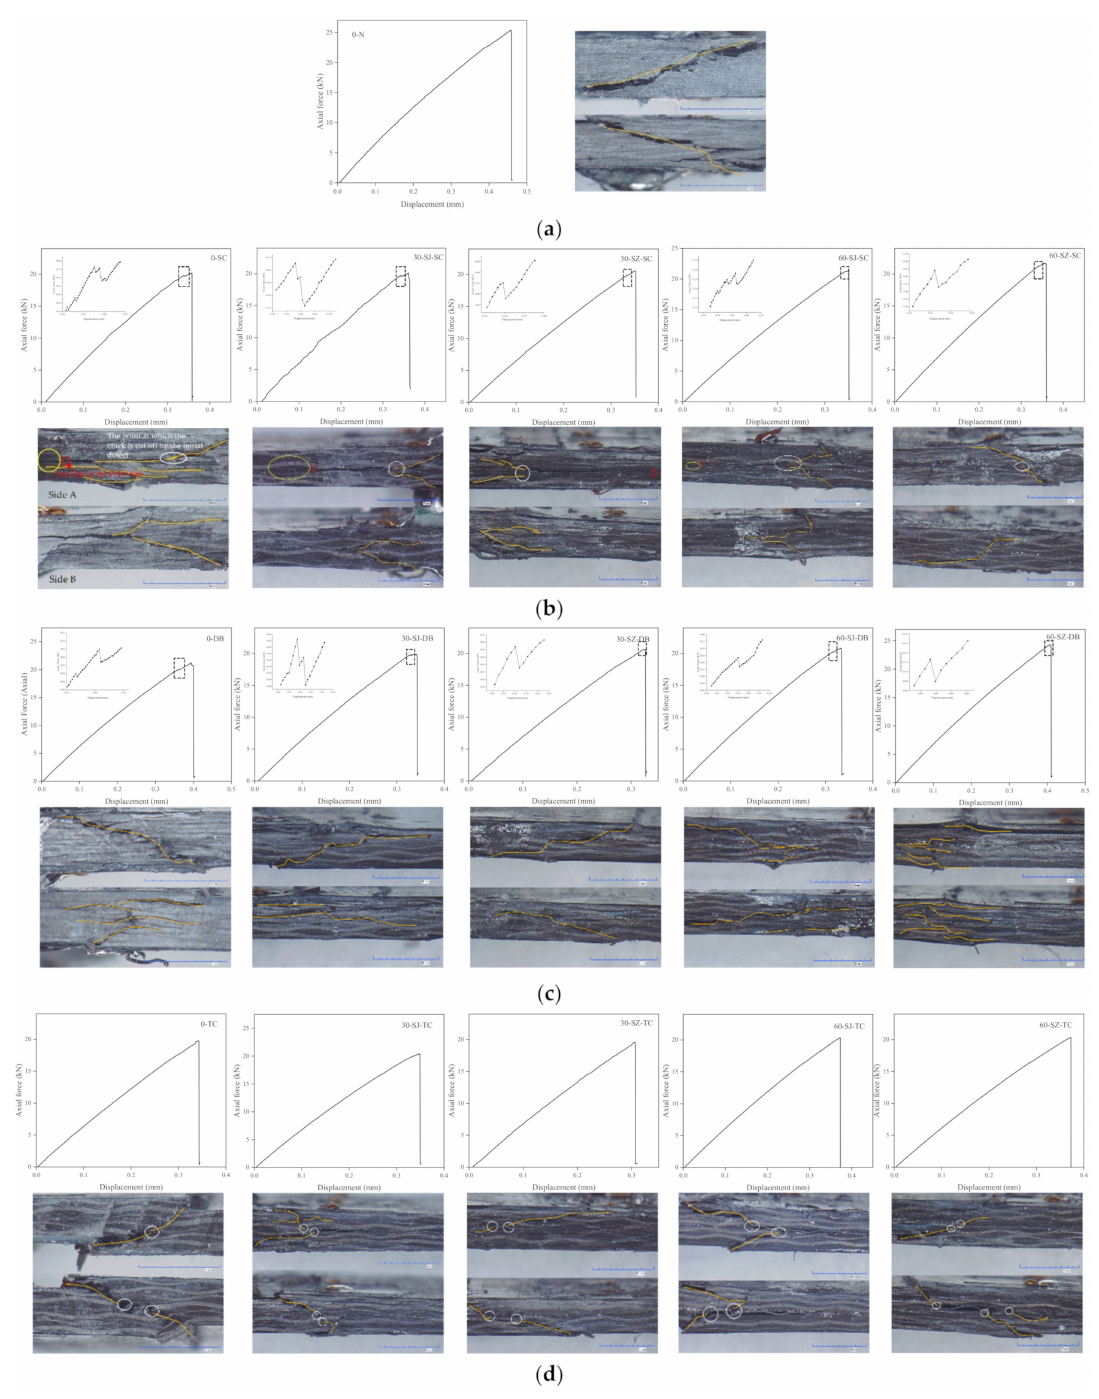
Figure 10. The load-displacement curves and damage morphologies of ( a ) the 0-N group, ( b ) the SC group, ( c ) the DB group, and ( d ) the TC group